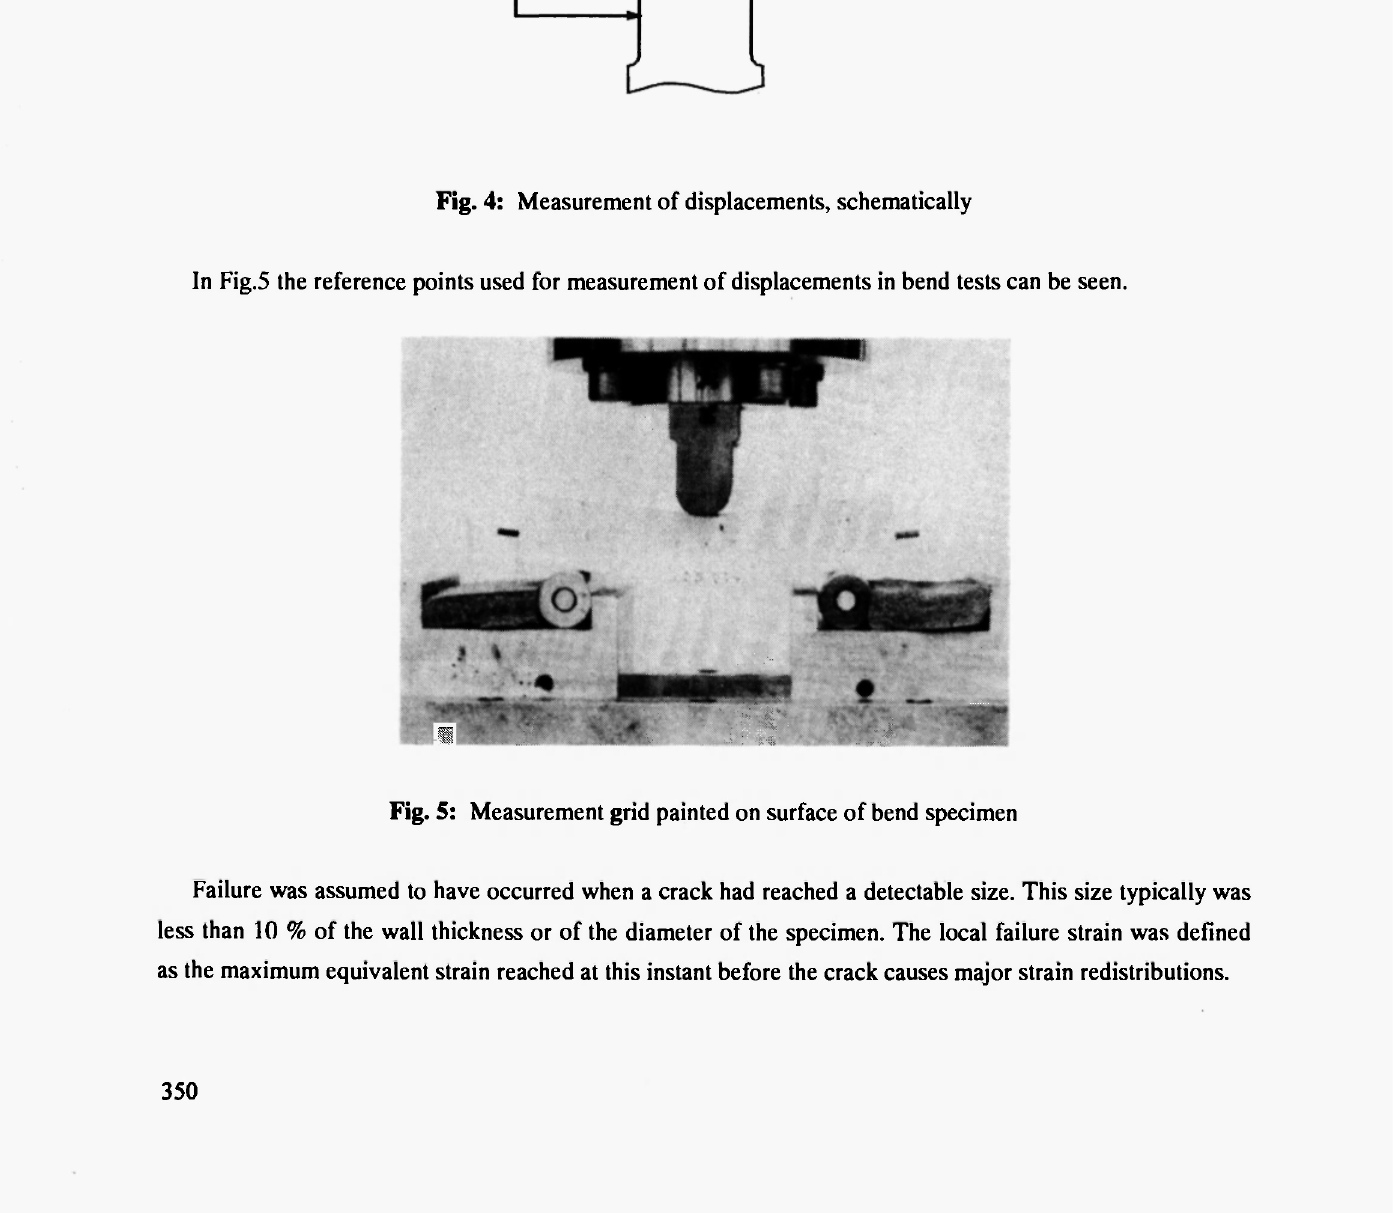
Fig. 4: Measurement of displacements, schematically